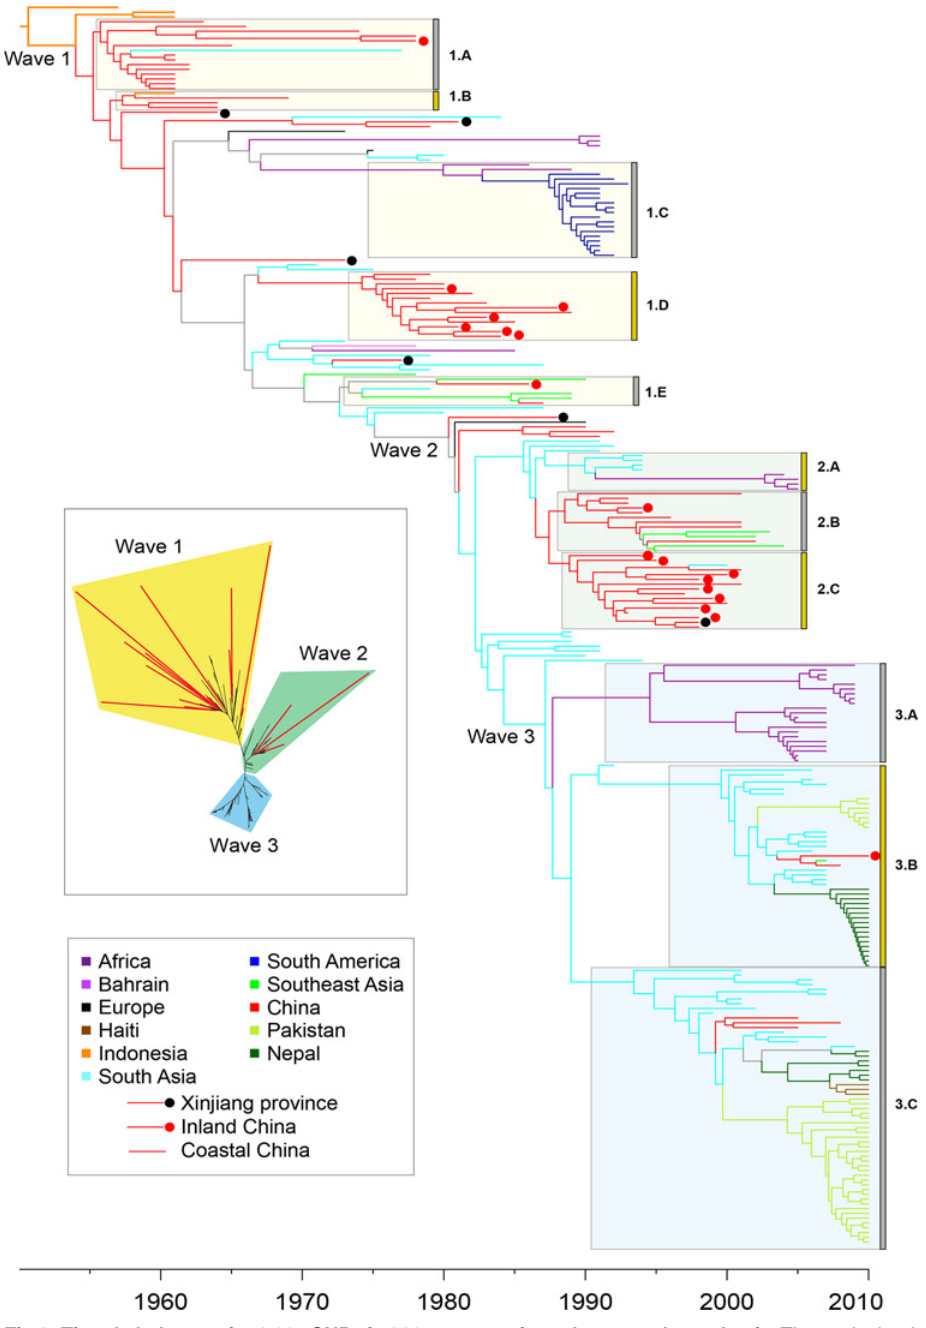
Fig 3. Timed phylogeny for 6,335 SNPs in 260 genomes from the seventh pandemic. The vertical order is the same as in S1A Table. Branches are colored according to inferred location as shown in the legend at the lower left, with the exception of branches for which the location was uncertain which are shown in gray. Isolates from China are subdivided into isolates from Xinjiang (black dot), inland provinces (red dot) and coastal provinces (no dot). Selected clades of multiple, closely related isolates are indicated by grey boxes next on the left of the clade designations (1.A, 1.B, etc). Inset: Maximum likelihood tree of the same data with significantly longer branches according to S3 Fig indicated in